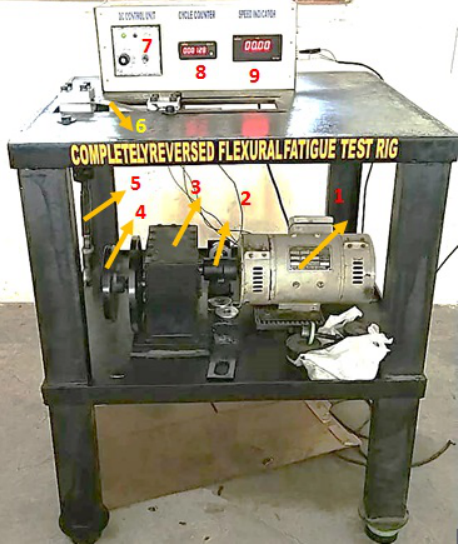
Fig. 7. Experimental set-up developed for completely reversed bending fatigue test (1) DC Motor (2) Coupling (3) Gear Box (4) Eccentric Crank (5) Linkage (6) Specimen (7) DC Control unit (8) Cycle counter (9) Speed Indicator. Table 2. Tensile strength and tensile modulus values of 4J, 4G, H1 and H2 laminates.